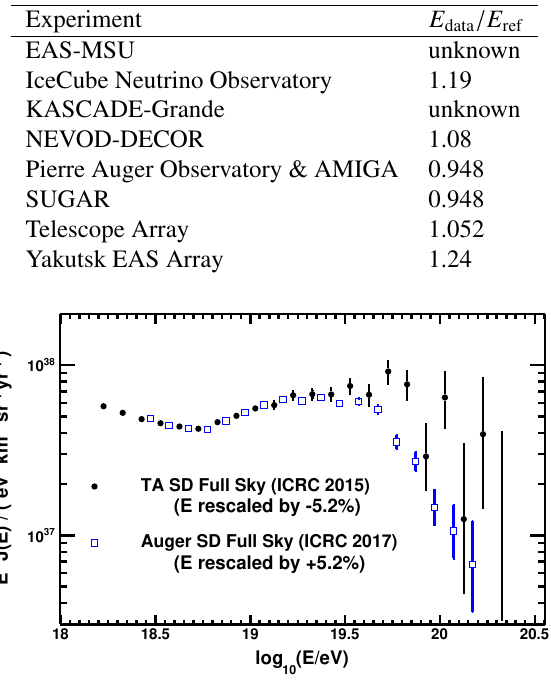
Figure 3. Relative cross-calibration of the energy scales of the Pierre Auger Observatory and Telescope Array by matching flux measurements, as presented by the Spectrum Working Group . Shown are the adjusted fluxes.